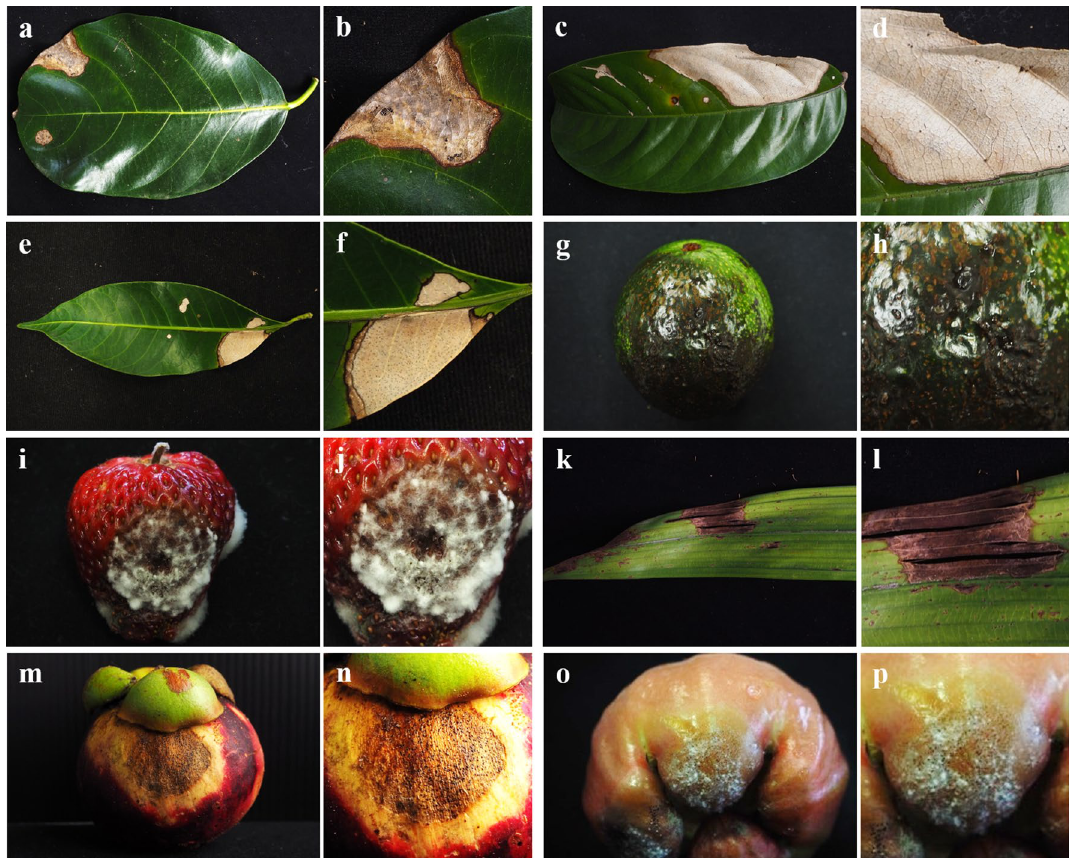
Figure 1. Symptoms of leaf blight and fruit rot on the original hosts caused by Neopestalotiopsis and Pseudopestalotiopsis . ( a , b ) Jackfruit leaves ( A. heterophyllus ); ( c , d ) rambutan leaves ( N. lappaceum ); ( e , f ) plum leaves ( B. macrophylla ); ( g , h ) avocado ( P. americana ); ( i , j ) strawberry ( F. × ananassa ); ( k , l ) leaves of snake fruit ( S. zalacca ); ( m , n ) mangosteen ( G. mangostana ); ( o , p ) rose apple ( S. samarangense